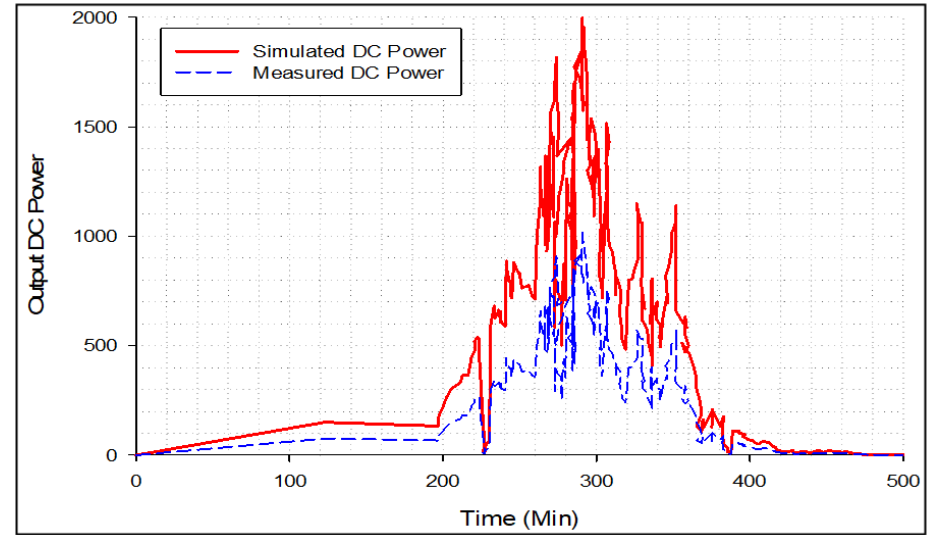
Figure 12. DC simulated power versus measured power (partial shading operation).